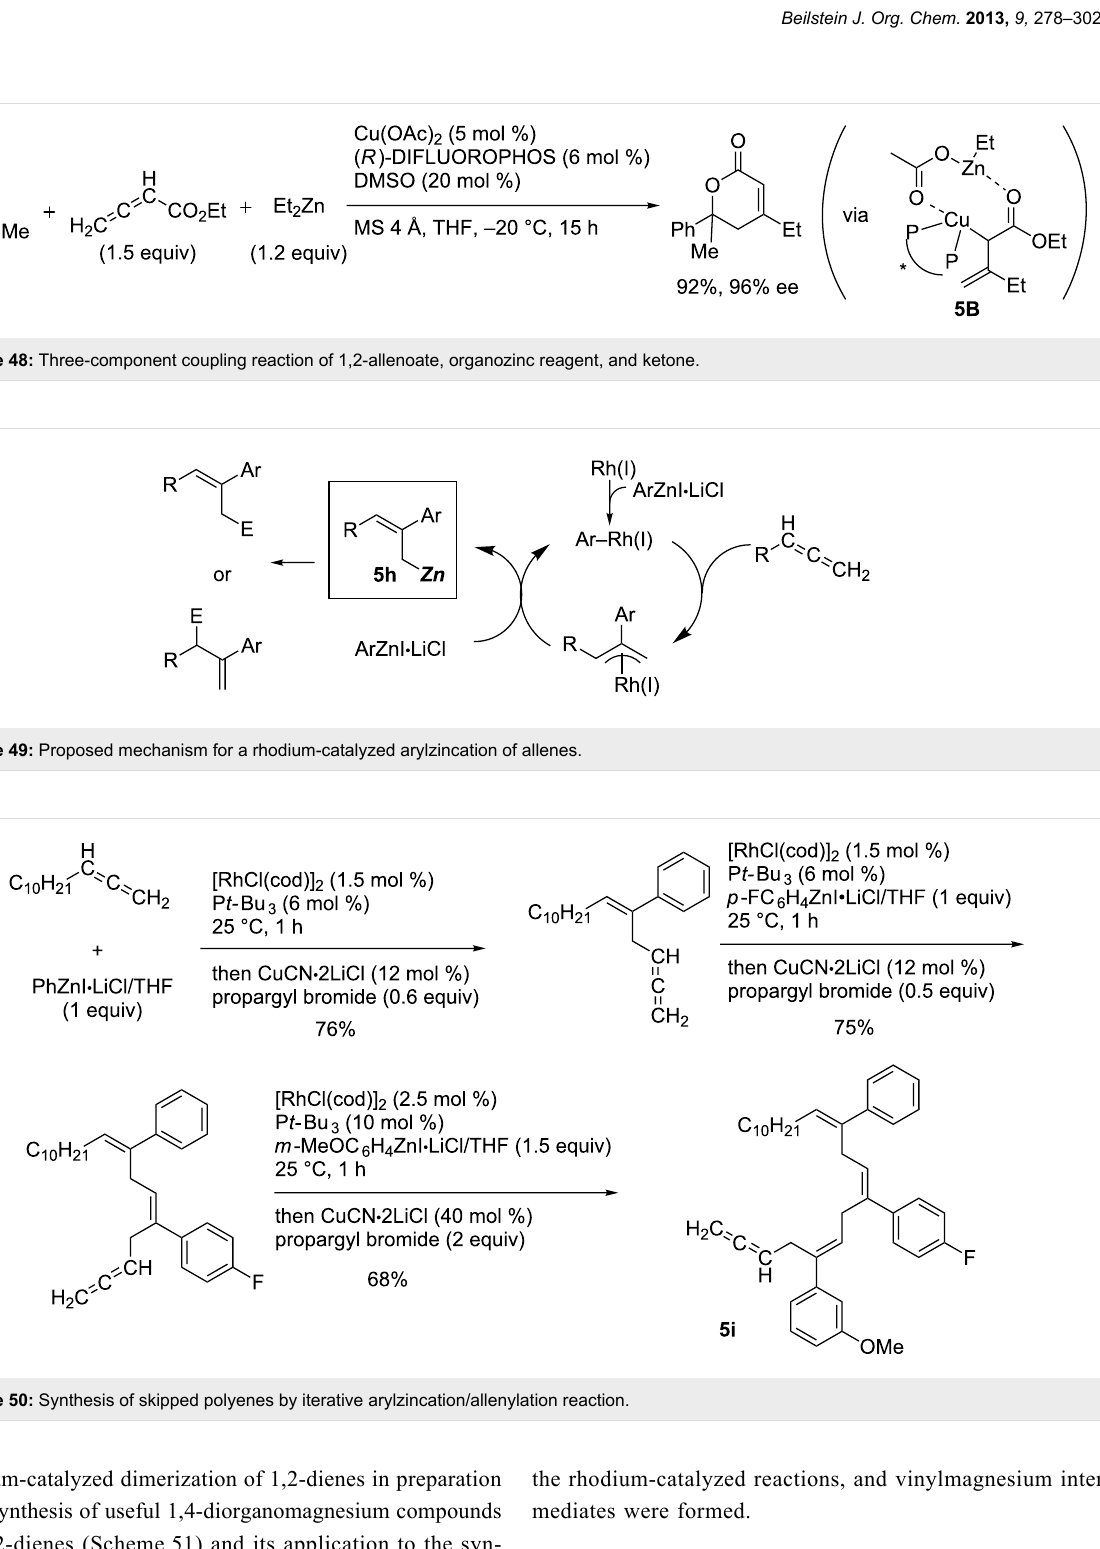
Zirconium-catalyzed dimerization of 1,2-dienes in